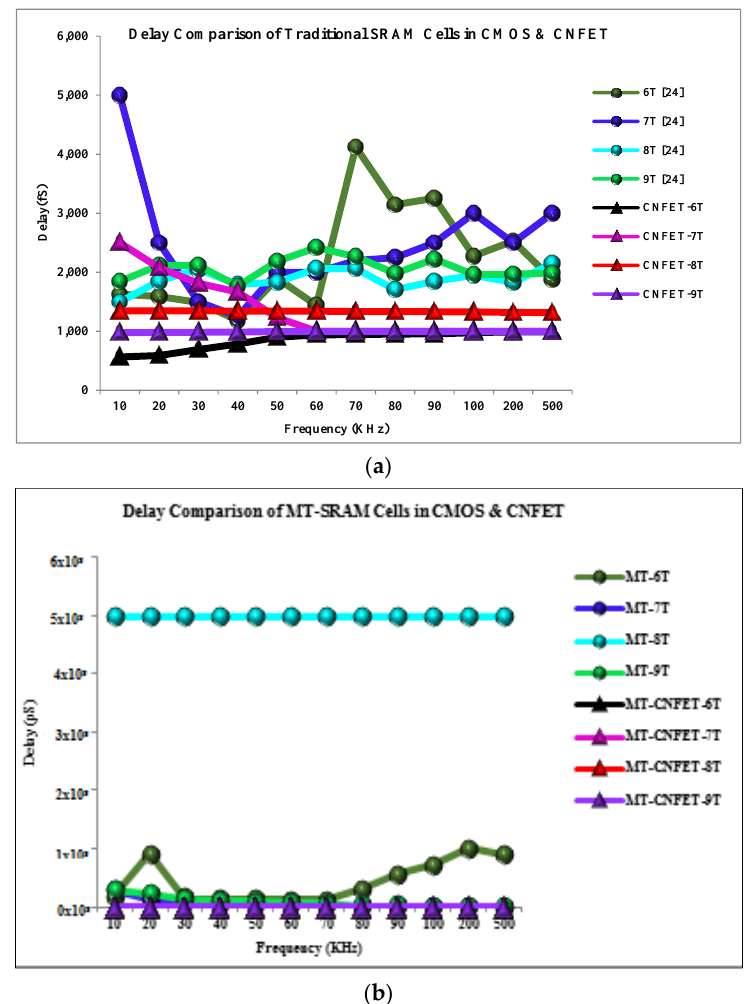
Figure 15. ( a ) Delay Comparison of Traditional SRAM Cells in CMOS and CNFET. ( b ) Delay Comparison of Proposed MT - SRAM Cells in CMOS and CNFET. Table 11. Delay Improvement (%)–CNFET 6T SRAM Cell vs. Other SRAM Cells.